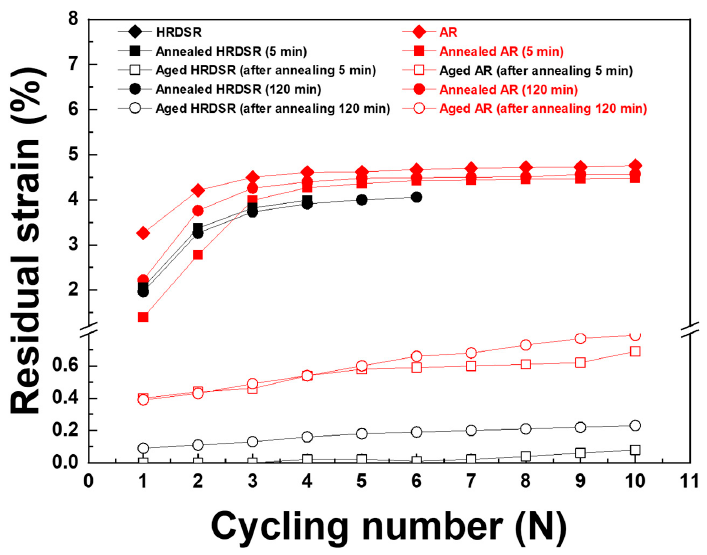
Figure 14. Residual strain as a function of cyclic number for the AR and HRDSR samples after an- nealing or annealing plus